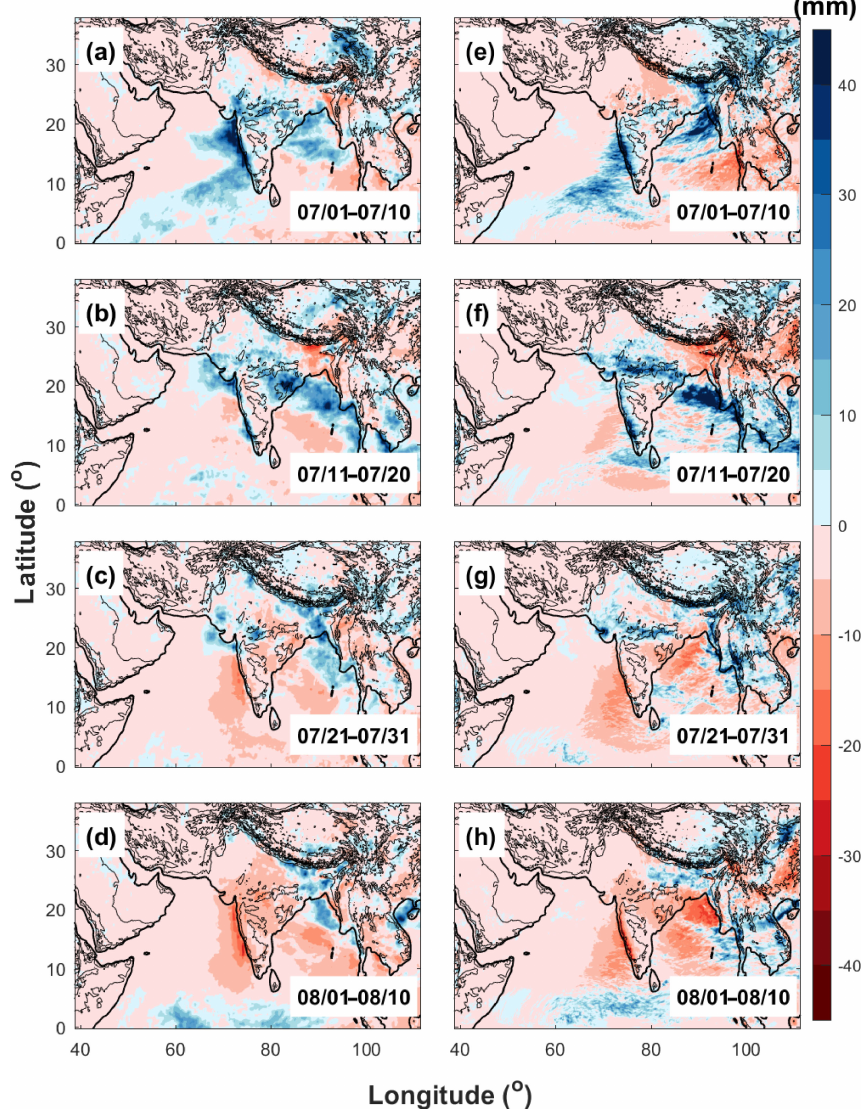
Figure 13. Spatial distributions of 10-day-averaged daily surface rainfall anomalies in (a, e) 1–10 July, (d, f) 11–20 July, (c, g) 21–31 July, and (d, h) 1–10 August, 2009 derived from TRMM (a, b, c, d) and WRF-gray (e, f, g, h)